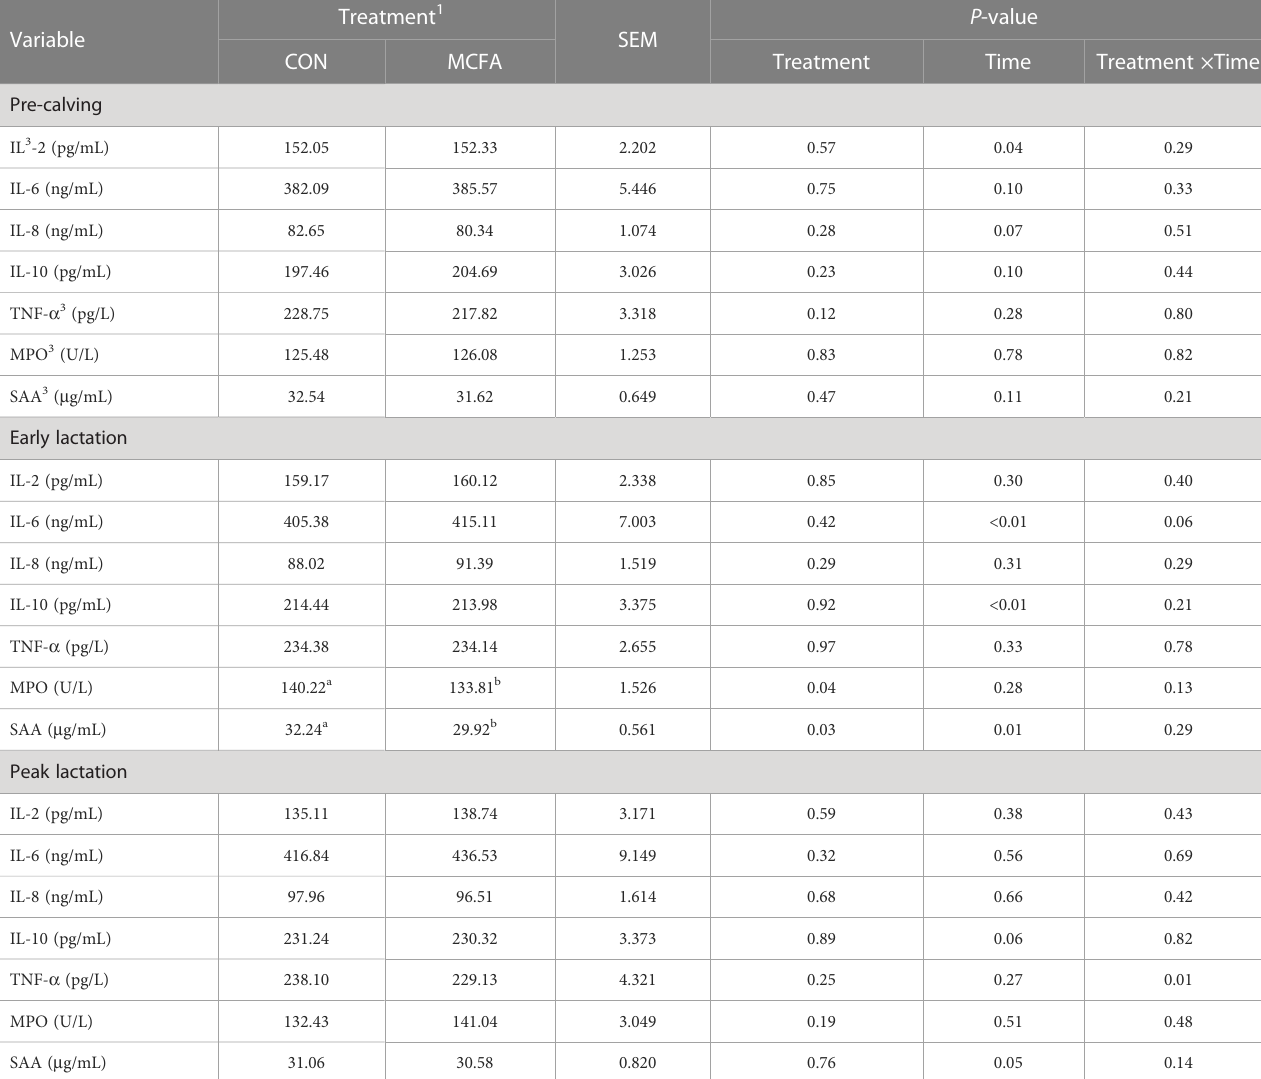
TABLE 5 Effects of feeding medium chain fatty acid on blood neutrophils phagocytosis of early lactation cows and peak lactation cows 2 . P -value Treatment 1 Variable SEM CON MCFA Treatment Time Treatment